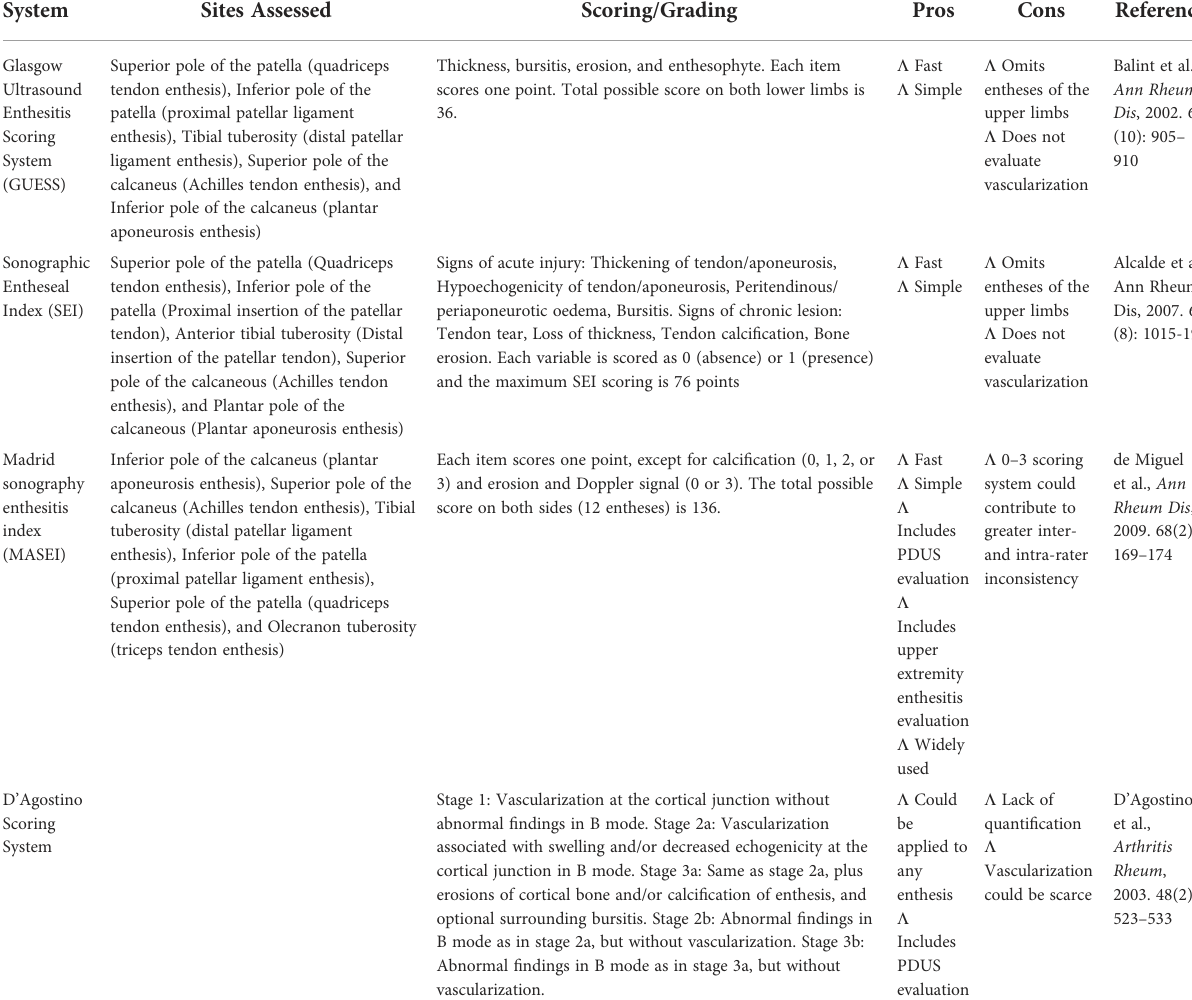
TABLE 4 Overview of common scoring or grading systems of enthesitis with ultrasound examinations in patients with SpA. System Sites